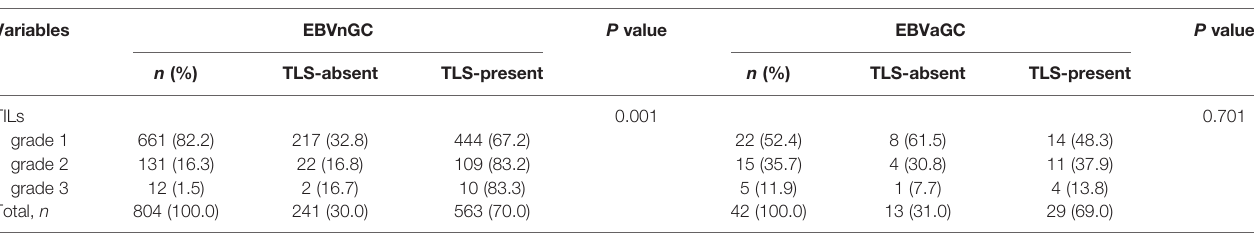
TABLE 3 | Association between TILs grade and TLS in EBVnGC and EBVaGC.